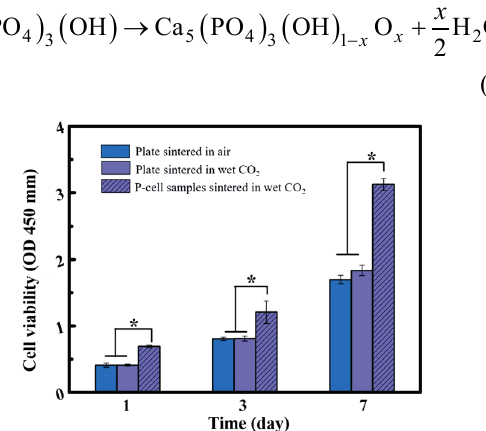
Fig. 12 Load-displacement curve for a typical compression test with the HA p-cell structure.